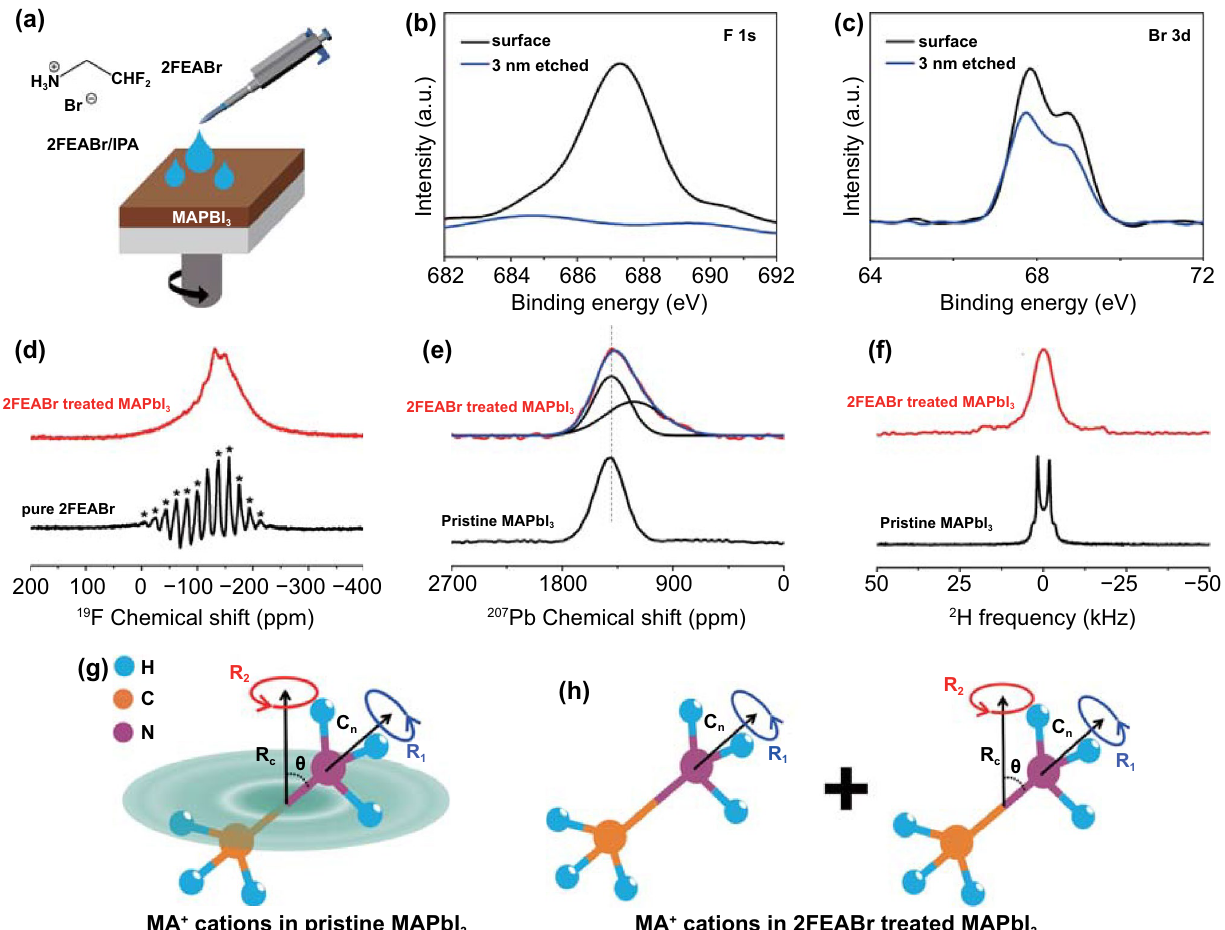
Fig. 1 a Schematics of 2FEABr post-treatment process and molecule structure of 2FEABr. b–c F 1 s and Br 3 d XPS core level spectra of 2FEABr treated perovskite film before and after surface etching. d 19 F MAS NMR. e 207 Pb NMR. f 2 H NMR. g–h Motion models of MA + cati- ons in pristine MAPbI 3 and in 2FEABr treated